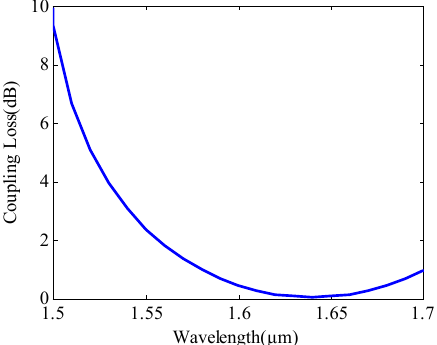
Figure 11. The coupling loss of the PCF.